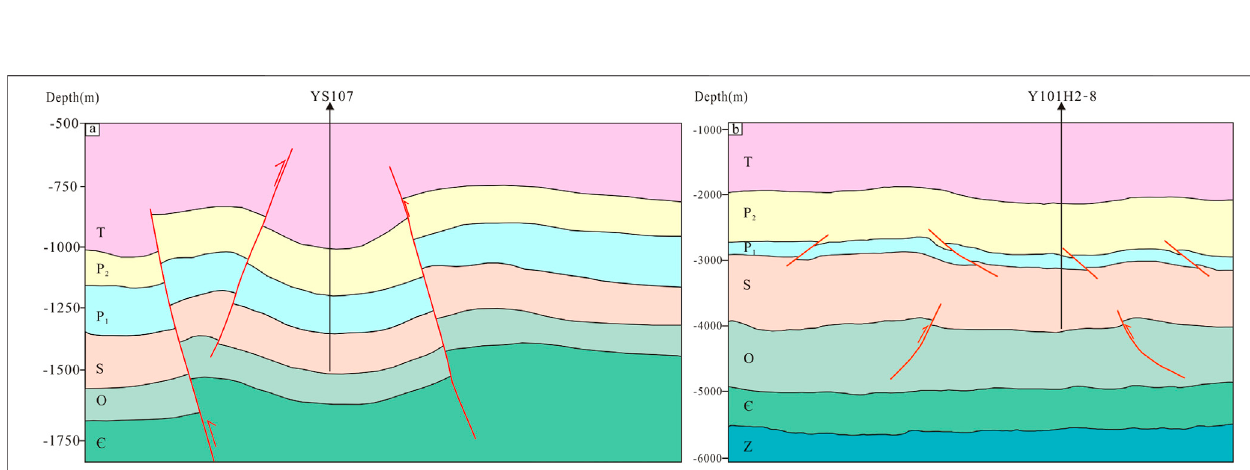
Frontiers in Earth Science |